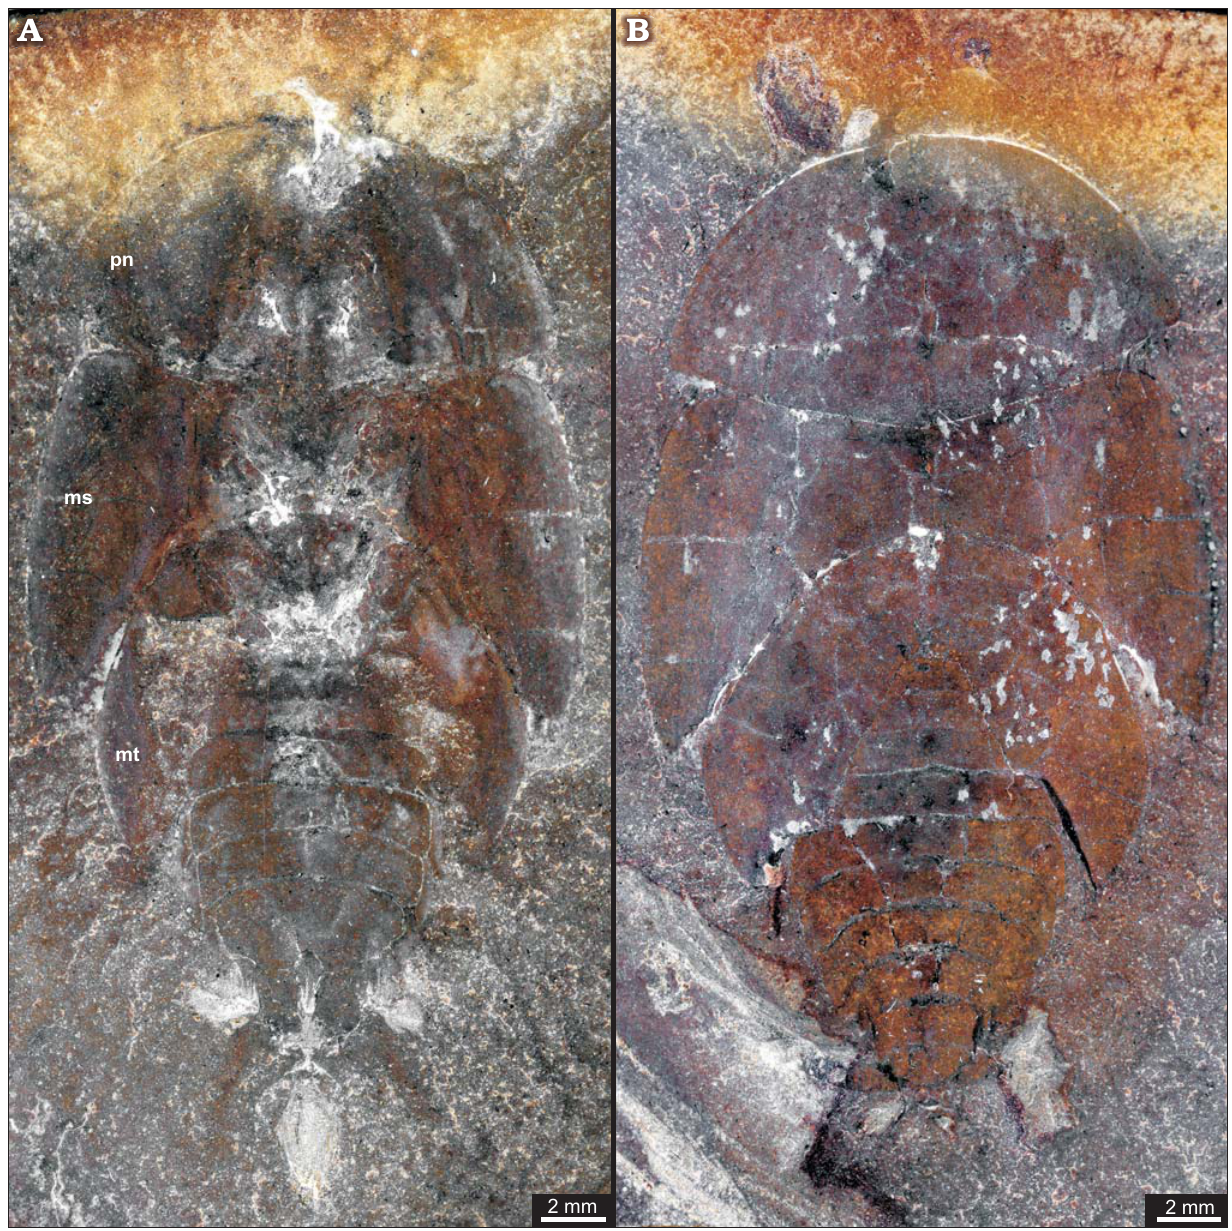
Fig. 6. Roachoid nymph YPM IP 027870 from the Carboniferous Carbondale Formation of Mazon Creek, USA; in dorsal view. Overview of part ( A ) and counterpart ( B ), thorax with visible parts of the coxa because of erosion of the median parts of thoracic tergites. Abbreviations: ms, tergite of mesothorax; mt, tergite of metathorax; pn, tergite of